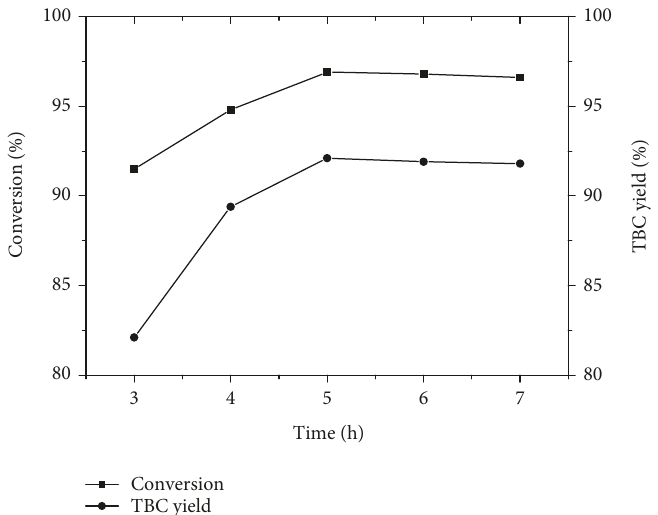
Figure 4: E ff ect of the reaction temperature on the esteri fi cation of citric acid with n-butanol. Reaction conditions: citric acid, 0.06mol; n- butanol, 0.3mol; catalyst, 6wt%; temperature, 115 °